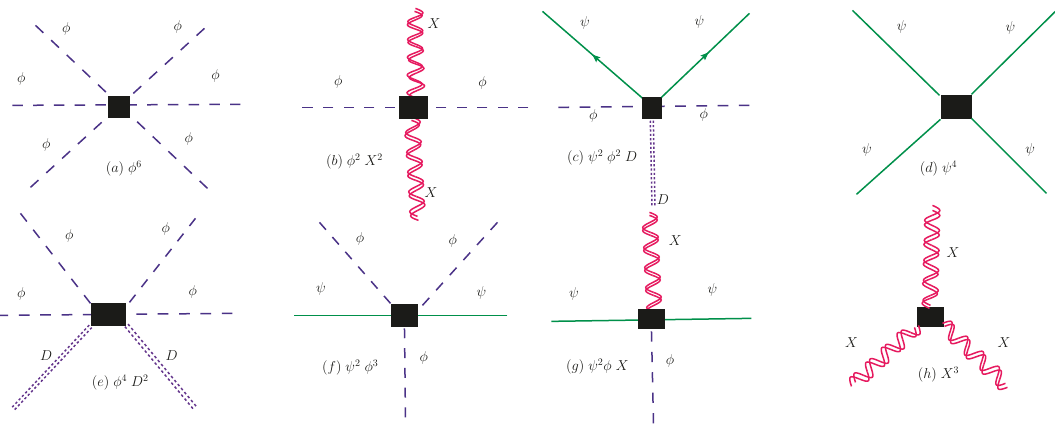
Figure 2. E(cid:11)ective operators in \Warsaw"-like basis representing the following class of operators: (a) (cid:30) 6 [6 + 7 2 = 20], (b) (cid:30) 2 X 2 [32], (c) 2 (cid:30) 2 D [14 + 10 (cid:2) (Baryon Number Conserving) + [4 2 = 8] (Baryon Number Violating), (e) (cid:30) 4 D 2 [8 + 6 (cid:2) (f) 2 (cid:30) 3 [24 2 = 48], (g) 2 (cid:30)X [16 2 = 32], (h) X 3 (cid:2) (cid:2)